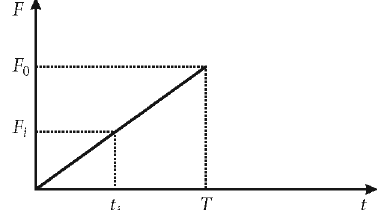
Fig. 1. The manner of imposing external ramping force upon the structure in FE software during its first loading sub-step